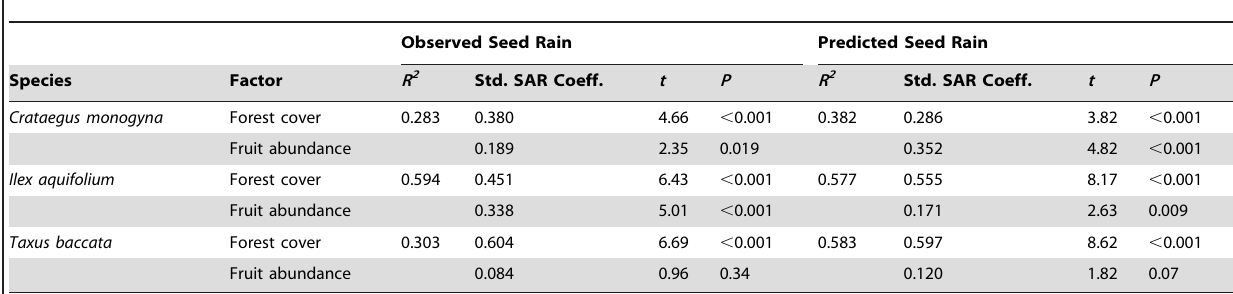
Table 3. Spatial Simultaneous Autoregressive Models (SAR) evaluating the relative effect of forest cover (arcsin sqrt proportion per cell) and fruit abundance (log number fruits per m 2 per cell, from all fruiting species) on seed rain for both observed (log seeds per m 2 per cell) and predicted seed rain (log seeds per cell; N =220 cells; R 2 indicates the proportion of variance of the response variable explained by predictors without space